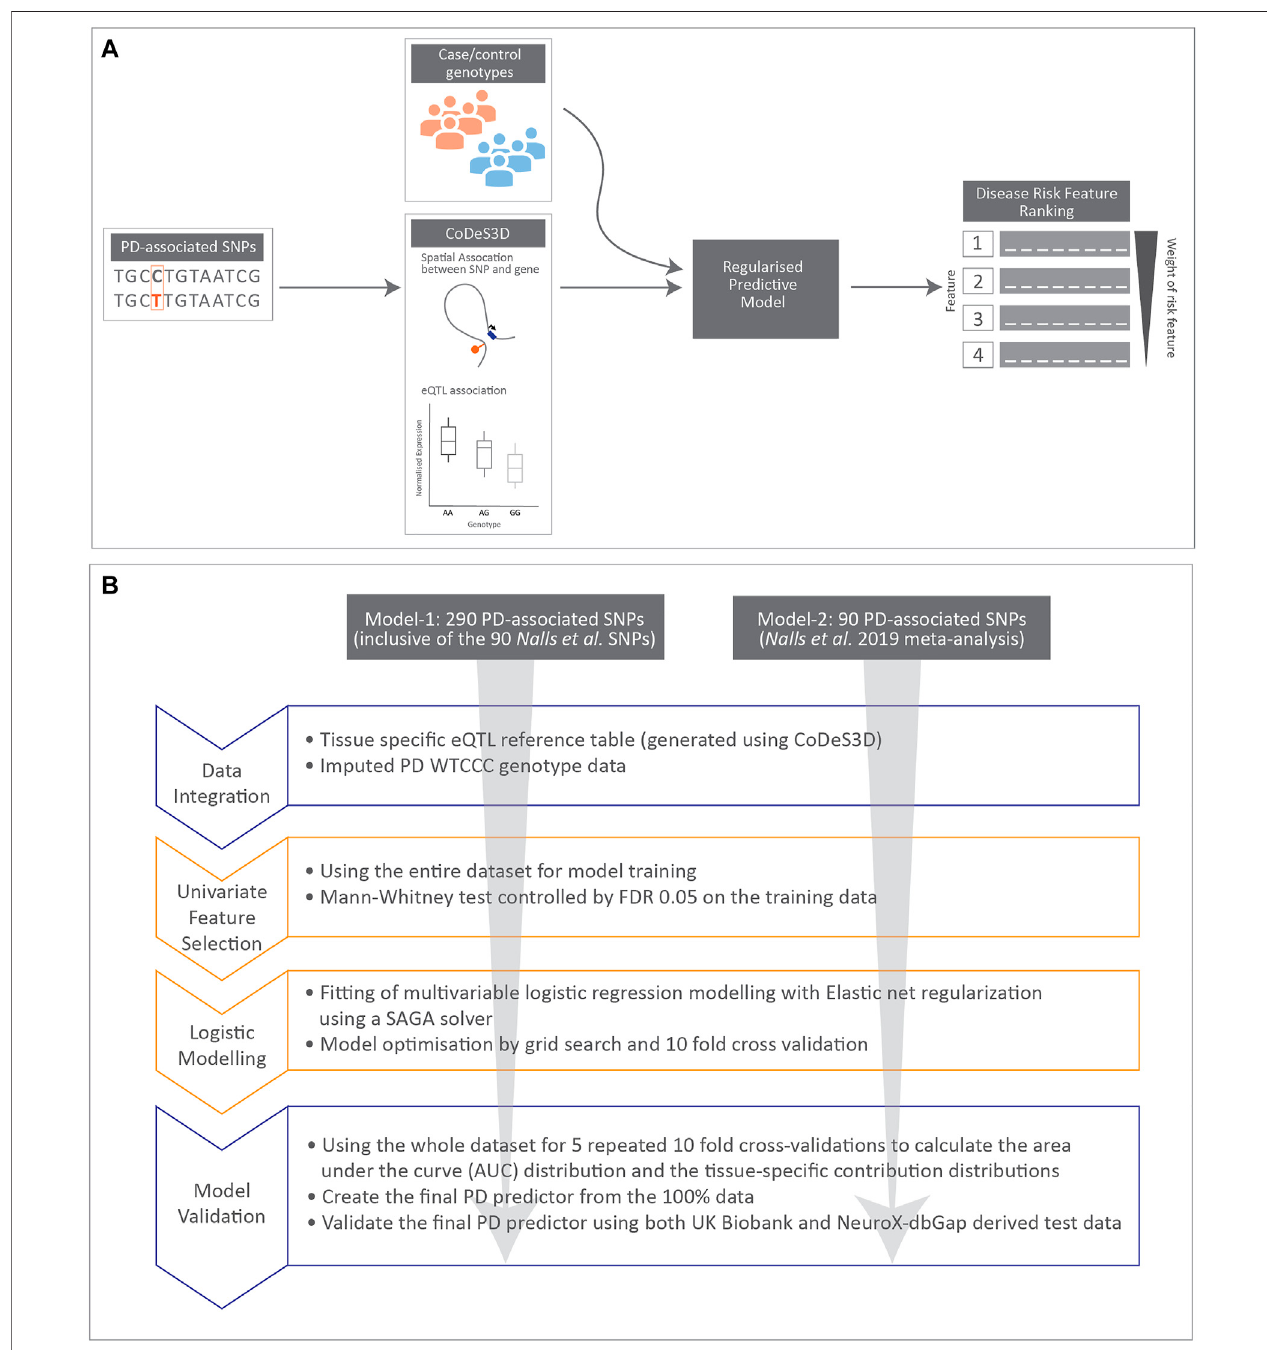
FIGURE1| Cartoonillustratingdataintegrationandwork fl owforregularisedlogisticregressionmodellingundertakeninthismanuscript. (A) Schematicdiagramfor data integration used to rank disease risk features. (B) Work fl ow used to create the two regularised logistic regression predictor models for PD.